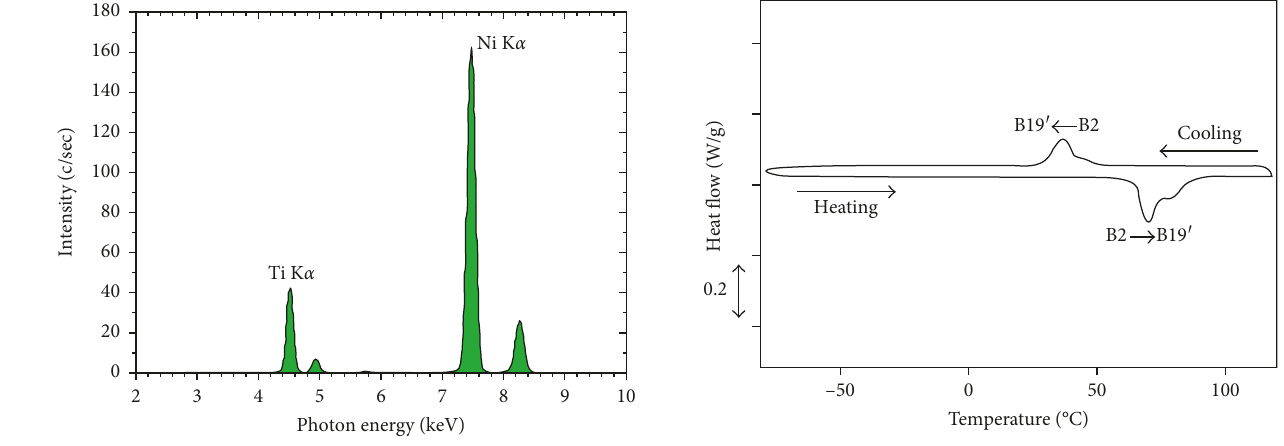
Figure 9: DSC curve for the NiTinol Ni50.8Ti (at.%) coating re- vealing its shape memory